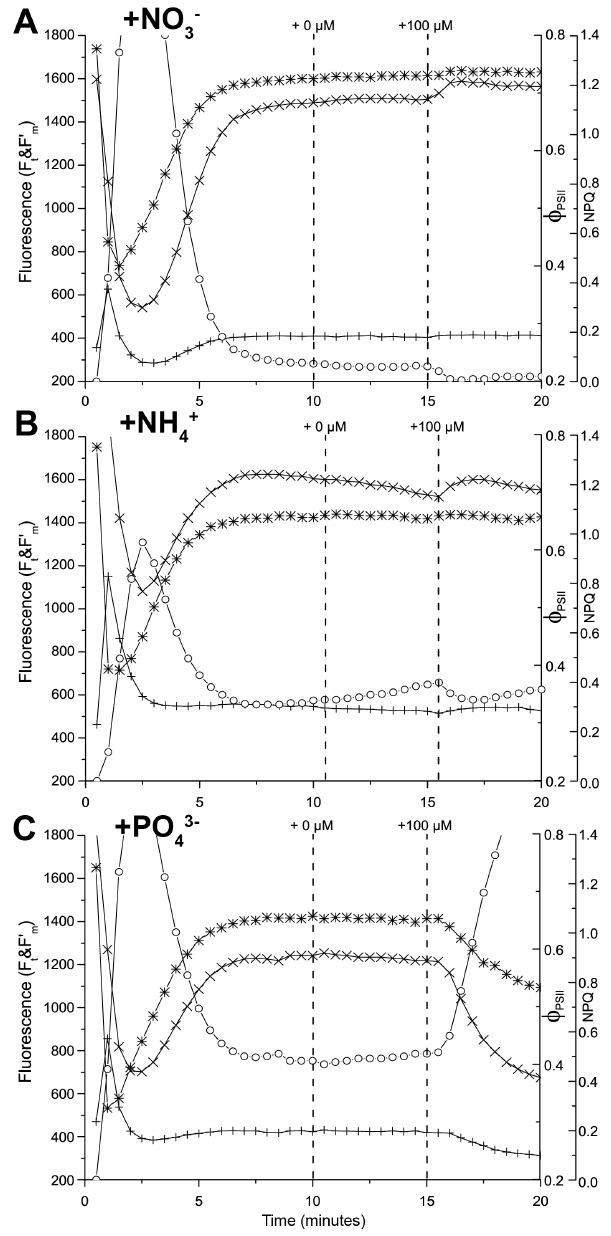
Figure 5. NIFT responses of Lobophoravariegata collected from the reef. Examples of the NIFT response to (A) NO 3 2 addition of a L. variegata leaf collected at Playa Kalki, (B) NH 4 + addition of a L. variegata leaf collected at Buoy 0, and (C) PO 43 2 addition of a L. variegata leaf collected at Buoy 0. The graphs show the time courses of steady-state fluorescence, F t ( + ); maximum fluorescence, F 9 m ( 6 ); the quantum yield of photosystem II, W PSII (); and non-photochemical quenching, NPQ ( # ). Vertical dashed lines indicate the timing of the control addition (0 m M) and different nutrient additions (all at 100 m M).